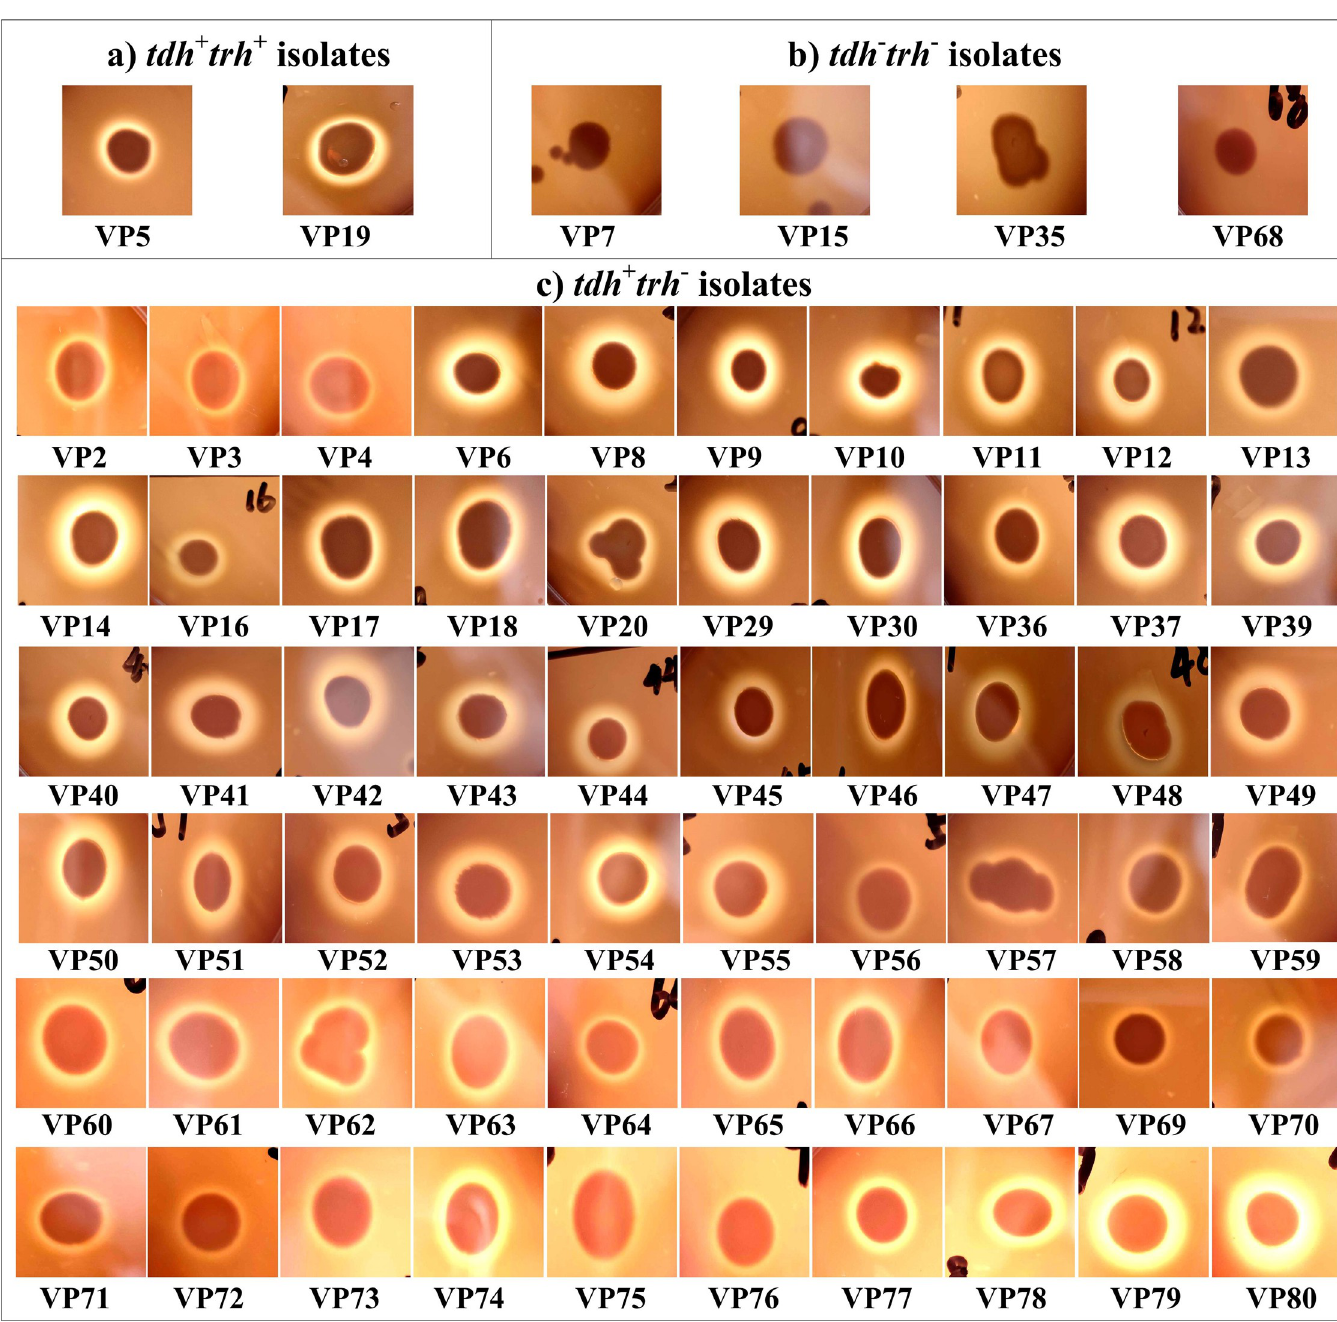
PLOS ONE | https://doi.org/10.1371/journal.pone.0273700 August 26,